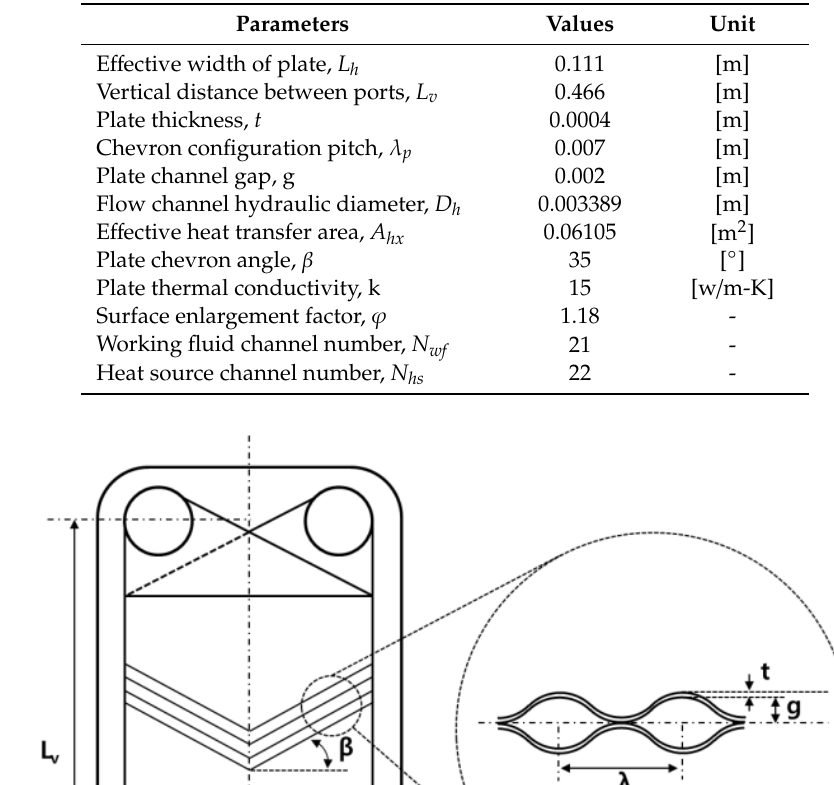
Table 3. Operating parameters of the chevron plate heat exchanger.